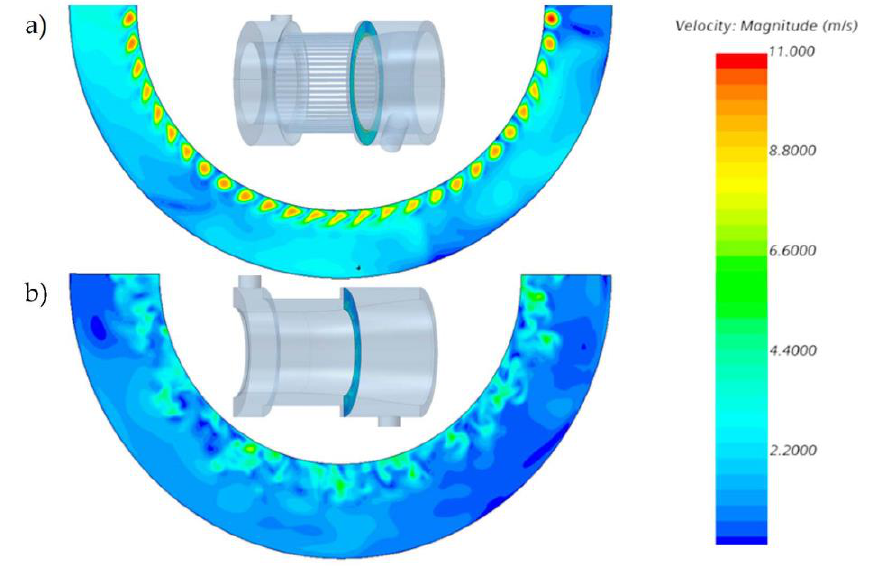
Figure 16. Velocity field map computed on a cross-Section 2 mm apart from the MC ( a ) and RR ( b ) regions.